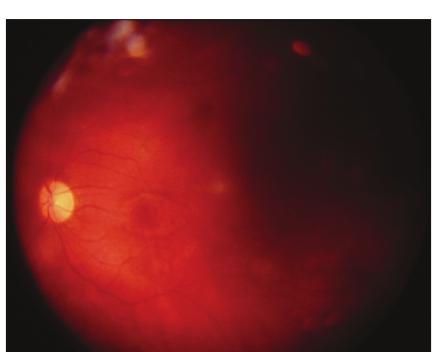
Figure 2: Color fundus picture depicting